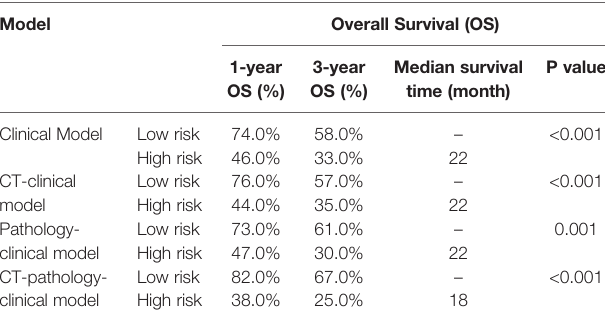
TABLE 4 | Overall survival of patients with ESCC in every